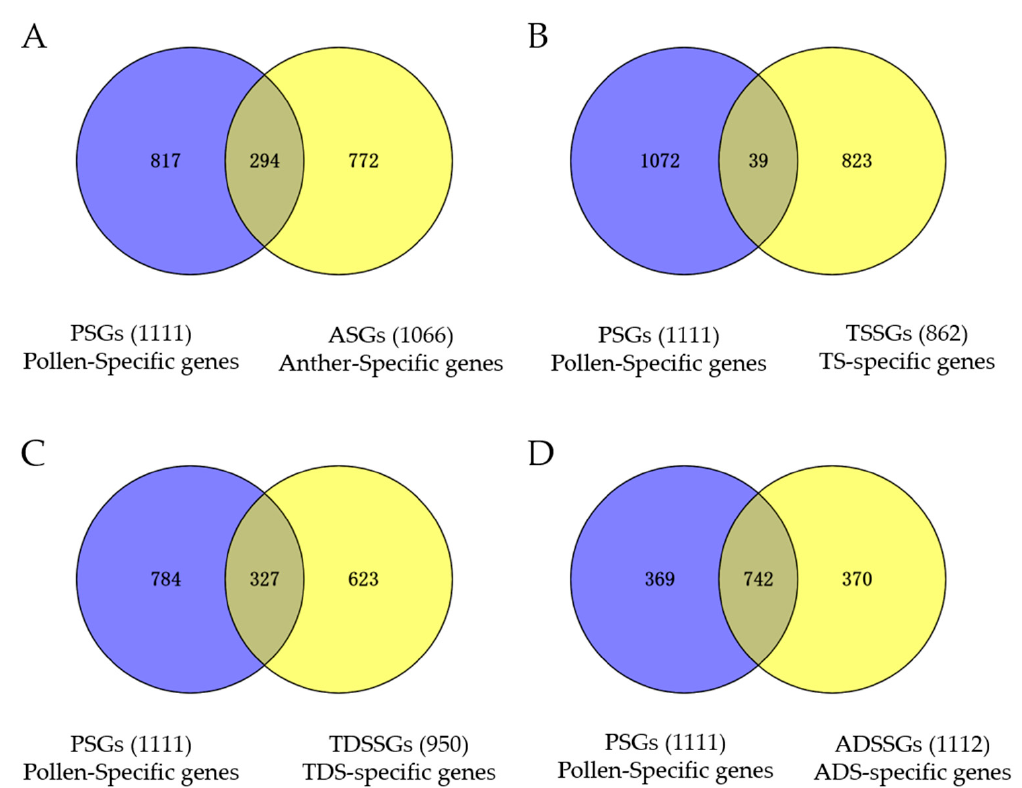
Figure 5. Venny plot analysis of APSGs, TSSGs, TDSSGs, and ADSSGs. ( A ) Identification of anther- and pollen-specific genes (APSGs) by using 1111 pollen-specific genes (PSGs) and 1066 anther- specific genes (ASGs); ( B ) Identification of tetrad stage- and pollen-specific genes (TSSGs) by using 1111 pollen-specific genes (PSGs) and 862 tetrad stage-specific genes (TSSGs); ( C ) Identification of tapetal degradation stage- and pollen-specific genes (TDSSGs) by using 1111 pollen-specific genes (PSGs) and 950 tapetal degradation stage-specific genes (TDSSGs); ( D ) Identification of anther dehiscence stage- and pollen-specific genes (ADSSGs) by using 1111 pollen-specific genes (PSGs) and 1112 anther dehiscence stage-specific genes (ADSSGs); In ( A – D ) the overlapped sets represent APSGs, TSSGs, TDSSGs and ADSSGs, respectively.